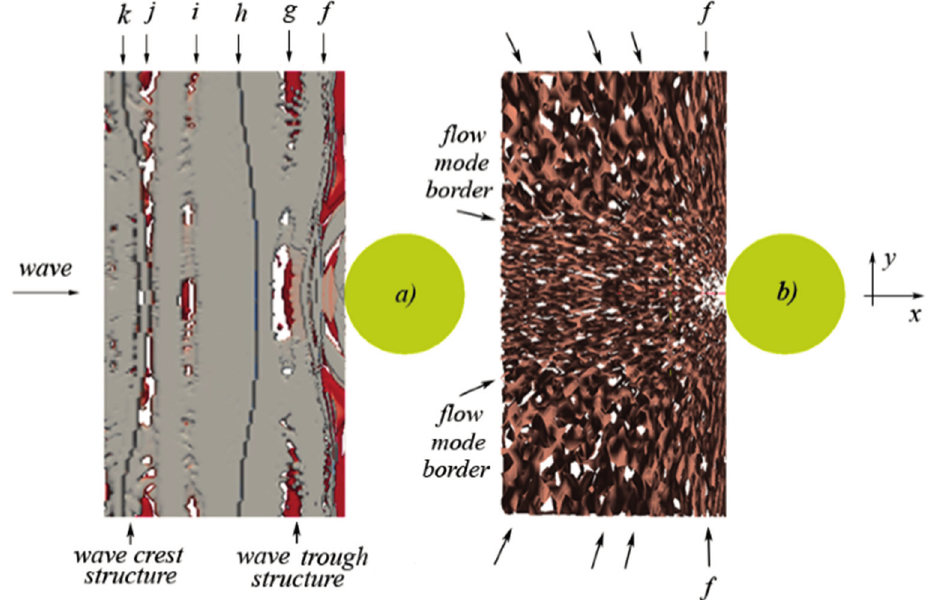
Figure 26. Flow-field representation at 0.500 T = ( T is wave period), top view (free-surface level): ( a ) flow-structures (colored with spanwise vorticity); ( b ) surfaces of constant x- velocity from reconstruction based on the three most energetic KL modes.